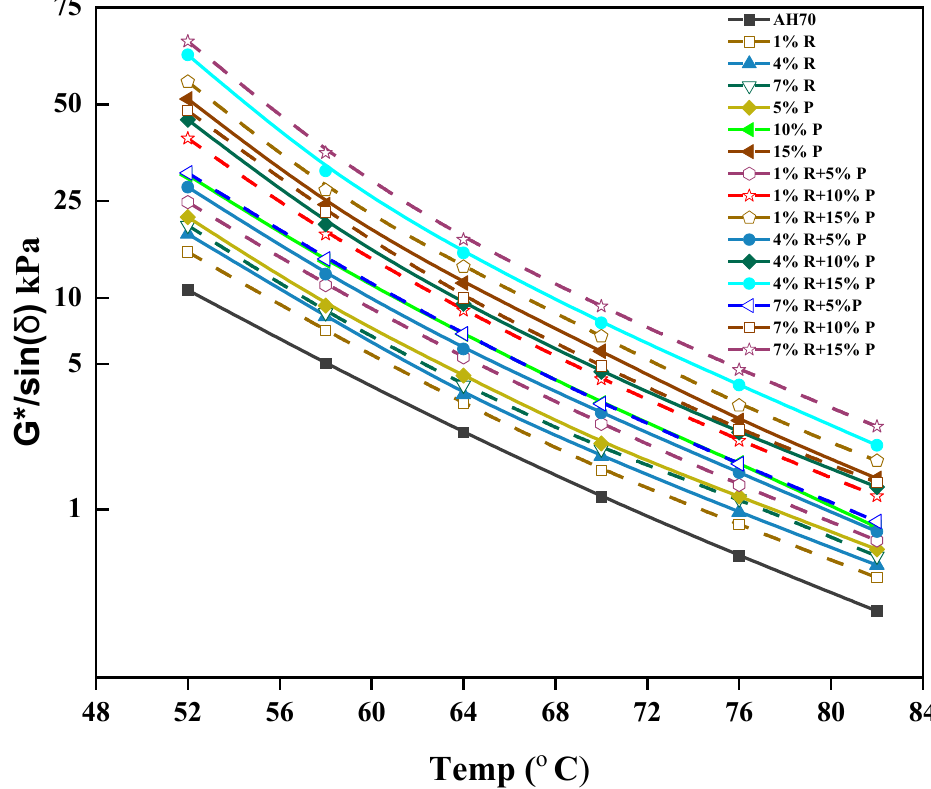
Figure 6. Effect of R/P, R, and P Content on Rutting Parameter G*/sin (δ).